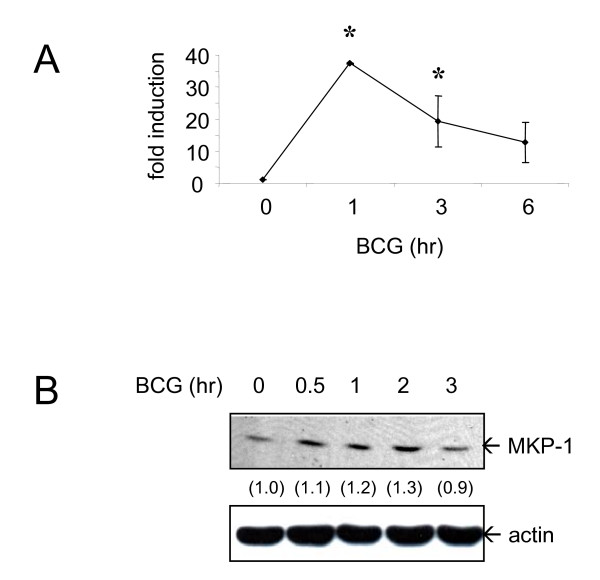
BCG induces MKP-1 expression. (A) Human monocytes were treated with BCG (MOI = 1 CFU/cell) for the indicated time points and RNA was harvested. MKP-1 level was assayed by using QPCR. Results are shown as mean ± SD from 3 different donors. * = p < 0.05. (B) Cells were treated as in (A) for the indicated time points and proteins were collected. MKP-1 protein levels were measured by Western blotting. Independent experiments were done on monocytes from 3 different donors and one representative set of results is shown. The intensities of the protein bands were determined by using Bio-Rad Quantity One imaging software. The intensities of MKP-1 were normalized to the corresponding actin. The values in parenthesis are the relative normalized intensities compared to those of untreated cells.